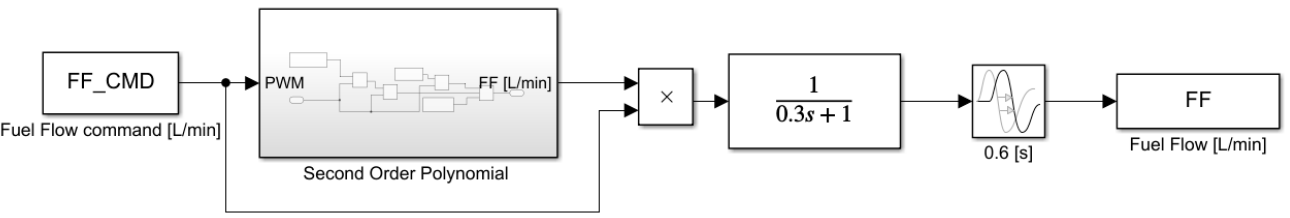
Figure 4. The implemented structure of the dynamic model of the fuel pump with non ‐ linear approximation.